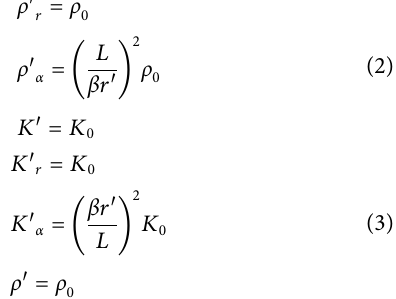
from Eq. 3 as: K r E = 2.25 GPa, K α E = 2.16 GPa, ρ